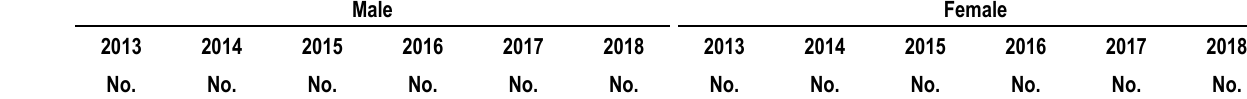
Table 8a. Diagnoses of HIV infection attributed to injection drug use, by selected characteristics, 2013–2018—United States (cont) Male